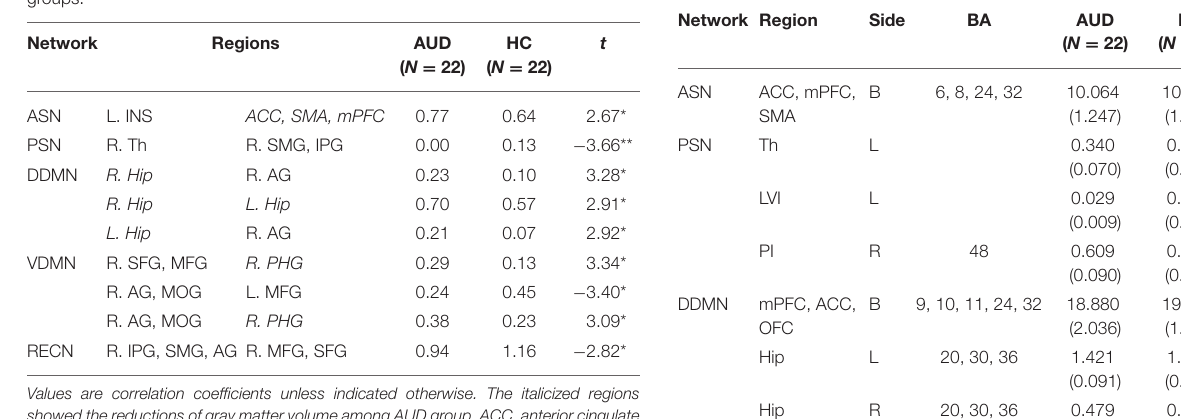
TABLE 2 | Difference in functional connectivity in each network between the groups. Network